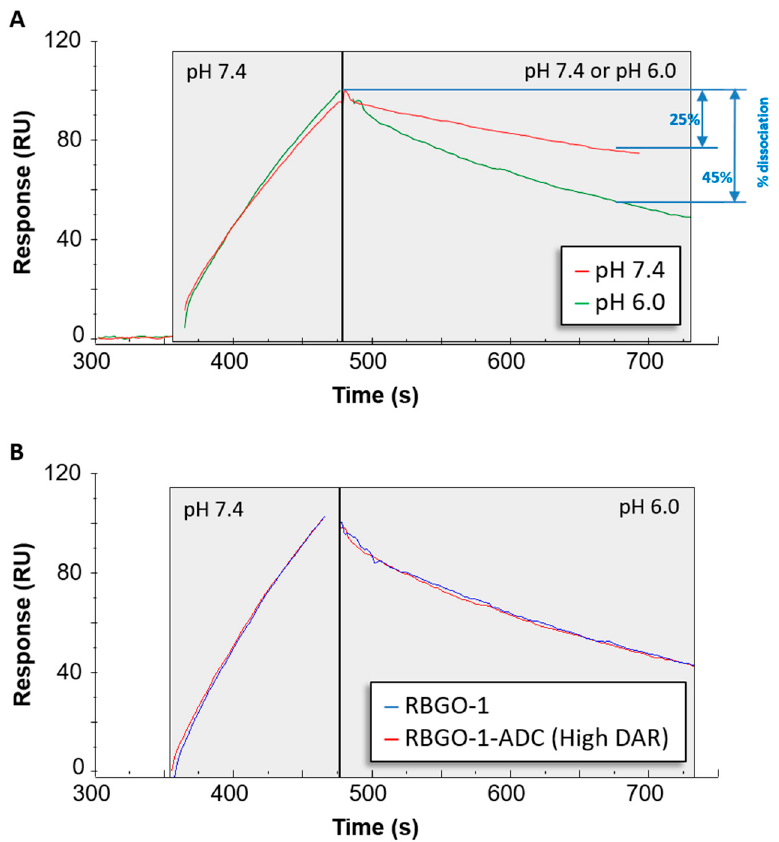
Figure 7. The dissociation rate of the RBGO1 antibody/ADC is increased in acidic pH. Antibody/ADC was captured to a Sensor Chip CM5 via amine coupled anti-mouse antibodies and binding/dissociation experiments were performed using rRAGE (10 nM). Using the dual-inject functionality transition from extracellular to endosomal conditions was mimicked. ( A ) rRAGE was injected in pH 7.4 buffer (extracellular) and allowed to bind to unconjugated RBGO-1, immediately followed by dissociation in either pH 6.0 (endosomal) or pH 7.4 buffer. ( B ) Overlapping sensorgrams showing similar binding profiles for unconjugated and conjugated antibody at the two different pHs. The sensorgrams shown are exemplars from three independent experiments.